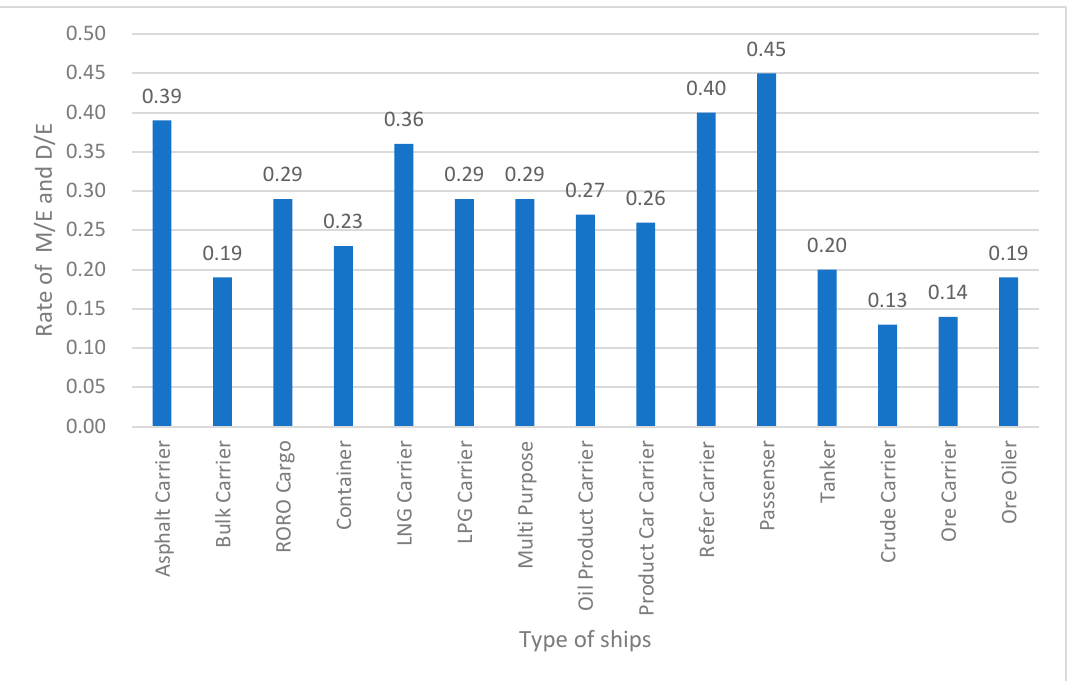
Figure 7. Proportion of fuel oil consumption and number of reported cases.